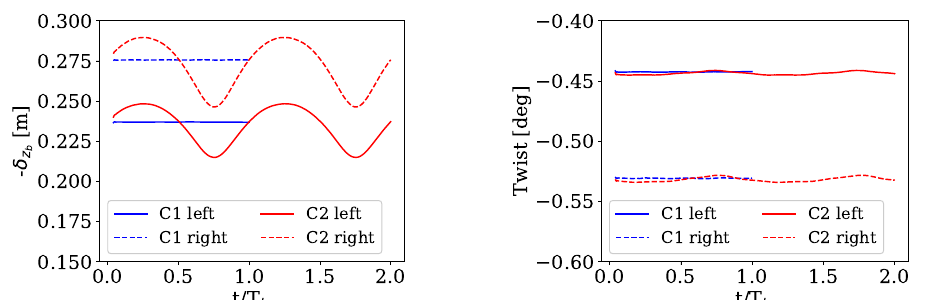
Figure 18. ( left ) Deflection and ( right ) twist deformation at the tip versus time for 1 loop (C1) crosswind flight with uniform inflow and 2 loops of (C2) crosswind flight with logarithmic inflow. The deflection for C2 varied with time; the twist deformation varied only slightly.